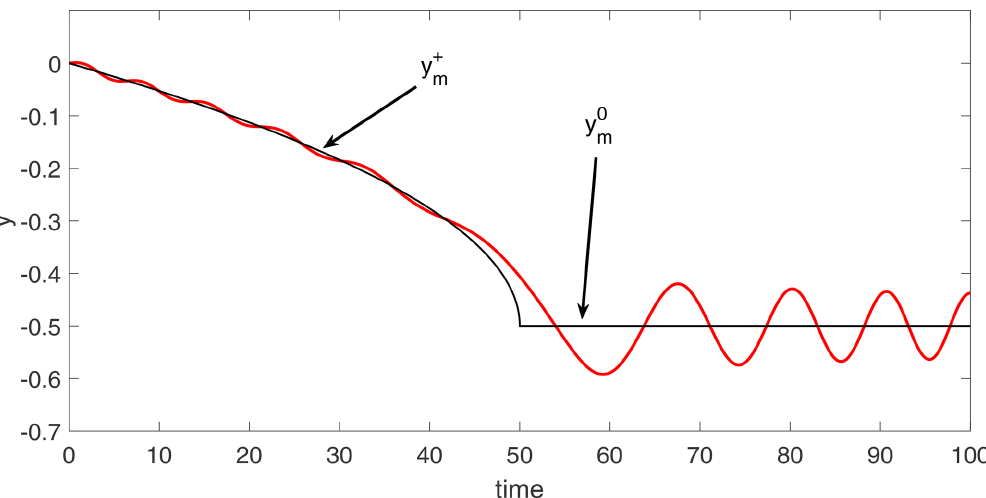
Figure 3. Numerical solutions of y(t) in Eqs. (2)–(5) starting from x = 0 = y = D and V = 0 . 002. The black curve shows the evolution of y + m (t) given by Eq. (11) for t < t cr and of y 0 m (t) given by Eq. (12) for t > t cr . The values of b = 2 and (cid:48) = 0 . 005 used here imply that the = 50. change between the two approximate solutions occurs at t cr = 1 2 b(cid:48)